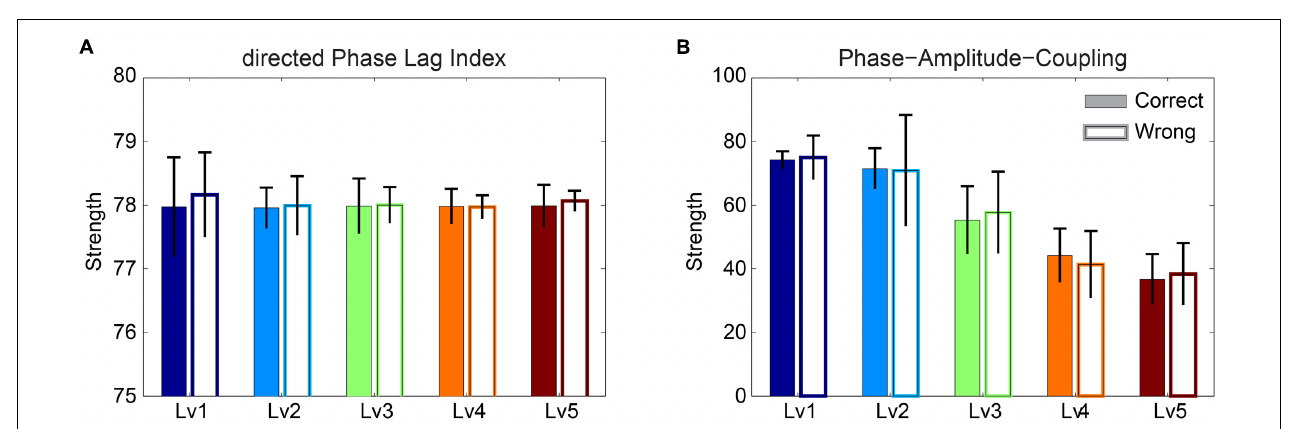
FIGURE 4 | Strength distribution of within- and between-phase interactions located over F brain regions: (A) within-phase interaction in Frontal (F θ ), (B) between-phase interaction in Frontal (F θ − α 2 ), (D) within-phase interaction in Parieto-Occipital (PO α 2 ), and (E) between-phase interaction in Parieto-Occipital (PO θ − α 2 ) and (C) cross-frequency coupling between them (F 2 × θ – PO α 2 ) for both correct and wrong answers. Bars represent mean ± standard deviations. No statistical significant differences were detected between correct and wrong trials.